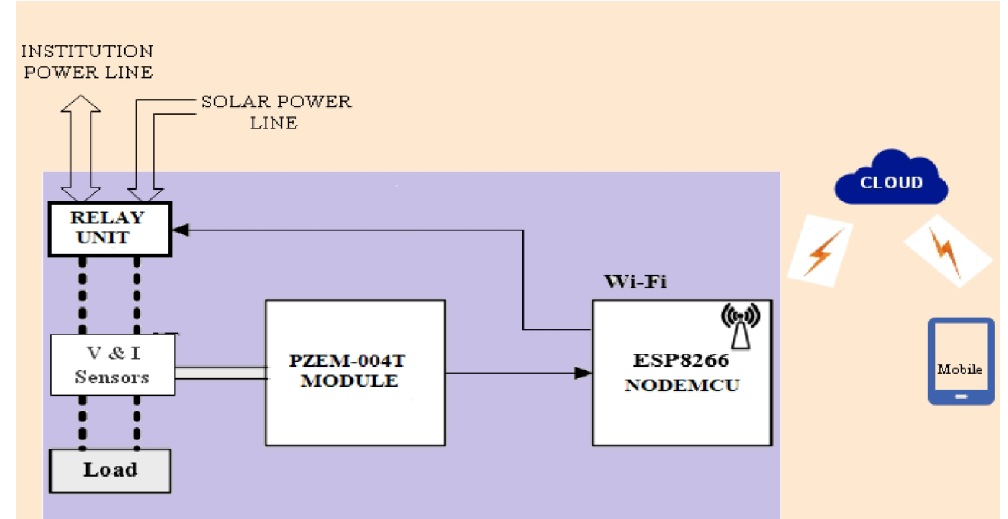
Figure 3. Illustration of the Smart Demand-Side Management System